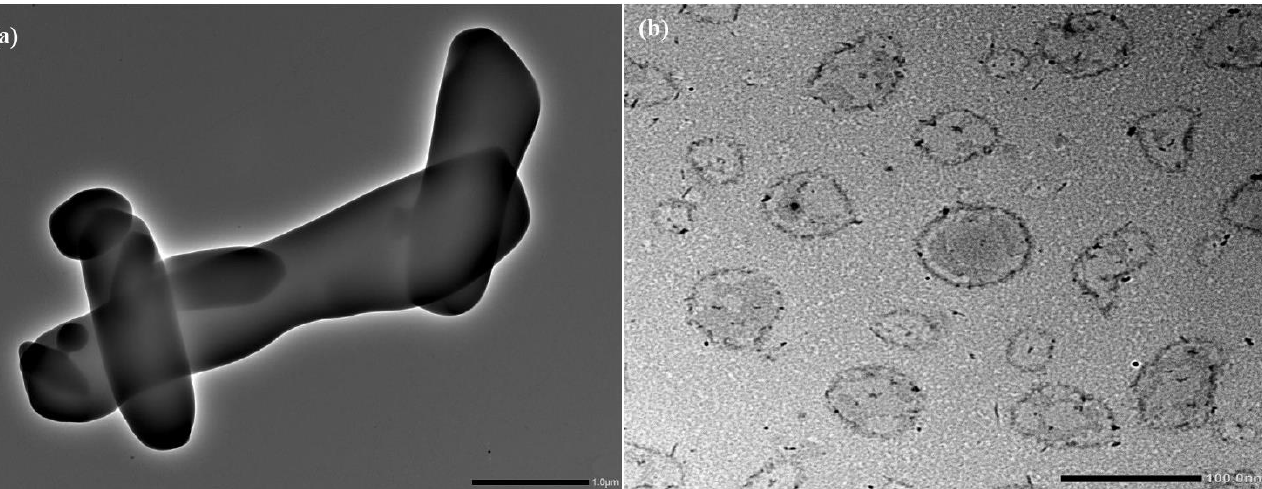
Figure 3. ( a ) DSC thermograms of RTG, Chitosan, Lecithin, Mannitol and lyophilized RTG-LCNP, ( b ) Surface morphology of the optimized RTG-LCNP by FESEM, ( c ) Surface morphology of pure crystalline RTG by FESEM.